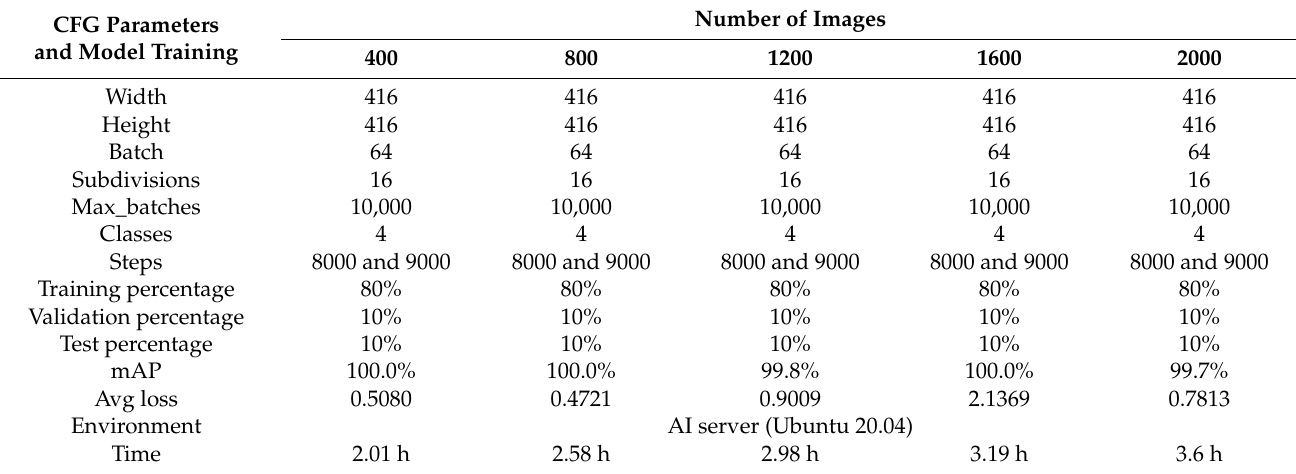
Table 2. Parameters and experimental results of each